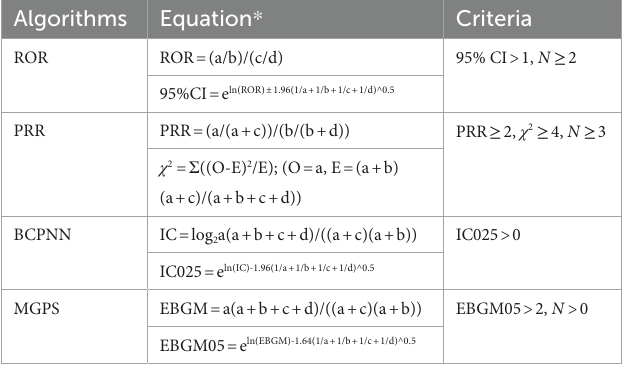
TABLE 1 Summary of major algorithms used for signal detection.